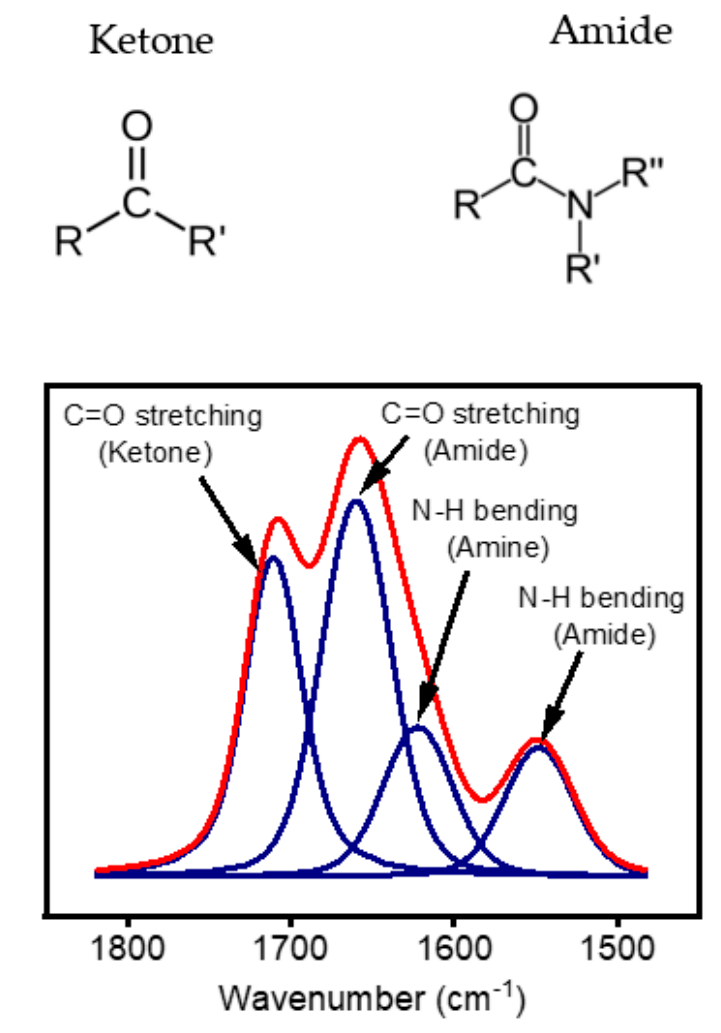
Figure 10. Curve fitting of FTIR spectra in the region between 1500 cm − 1 and 1800 cm − 1 to understand the nature of C=O coated on the surface by atmospheric pressure plasma surface treatment.